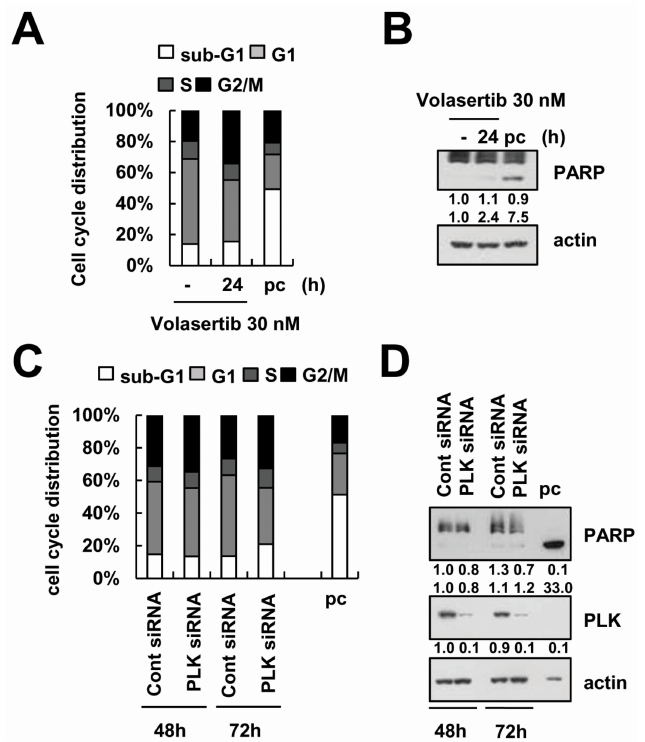
Figure 1. The effect of volasertib on cell cycle distribution and apoptosis in Caki cells. ( A , B ) Caki cells were treated with 30 nM volasertib for 24 h. The DNA content was analyzed by flow cytometer ( A ). The expression of PARP and actin were determined via Western blotting ( B ). ( C , D ) Caki cells were transiently transfected with control siRNA (Cont siRNA) or PLK siRNA for the indicated time periods. After transfection, the DNA content was analyzed with a flow cytometer ( C ). The protein levels of PARP, PLK, and actin were determined via Western blotting. The level of actin was used as a loading control ( D ). P.C.: positive control (10 ng/mL TNF- α plus 5 µ g/mL cycloheximide for 14